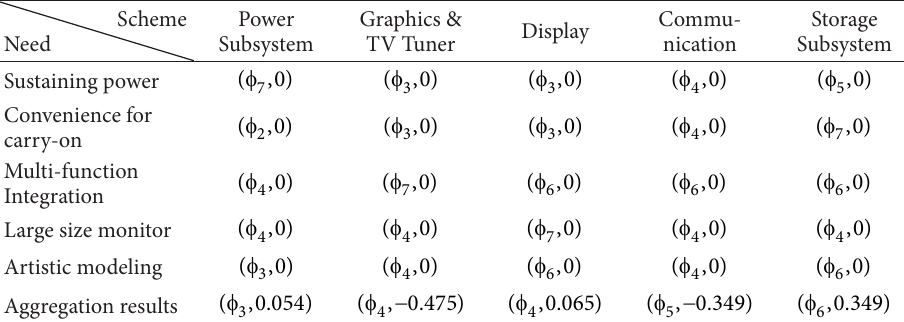
Commu- Storage Display nication Subsystem